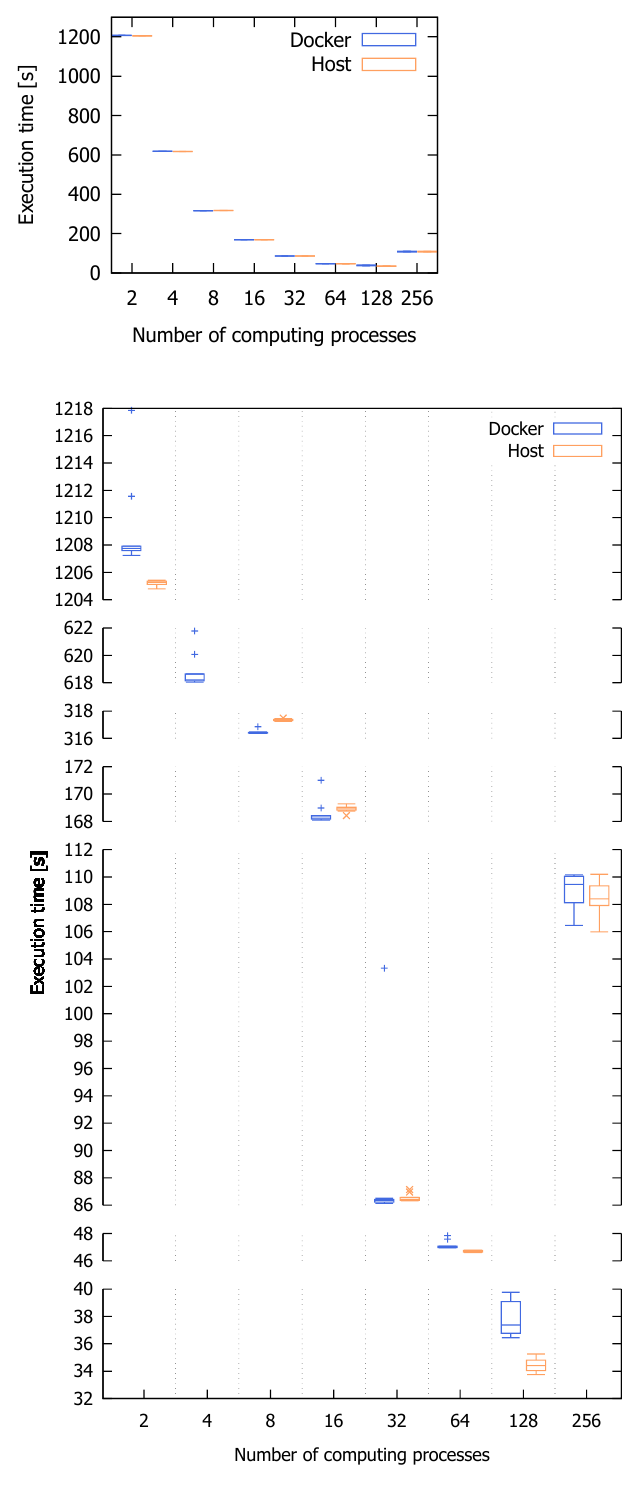
Figure 8. Execution times for SPMD, -O3 compilation flag; boxplot notation: medians, Q1 and Q3, max(Q1 − 1.5IQR, minimum) and min(Q3+1.5IQR, maximum) as well as potential outliers (+ for Docker, x for